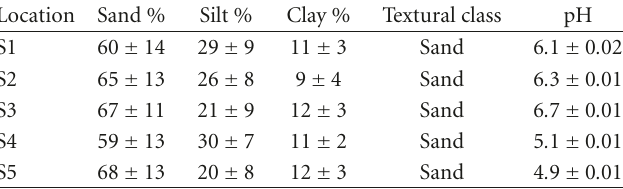
Table 2: Chemical and physical characteristics of soil.